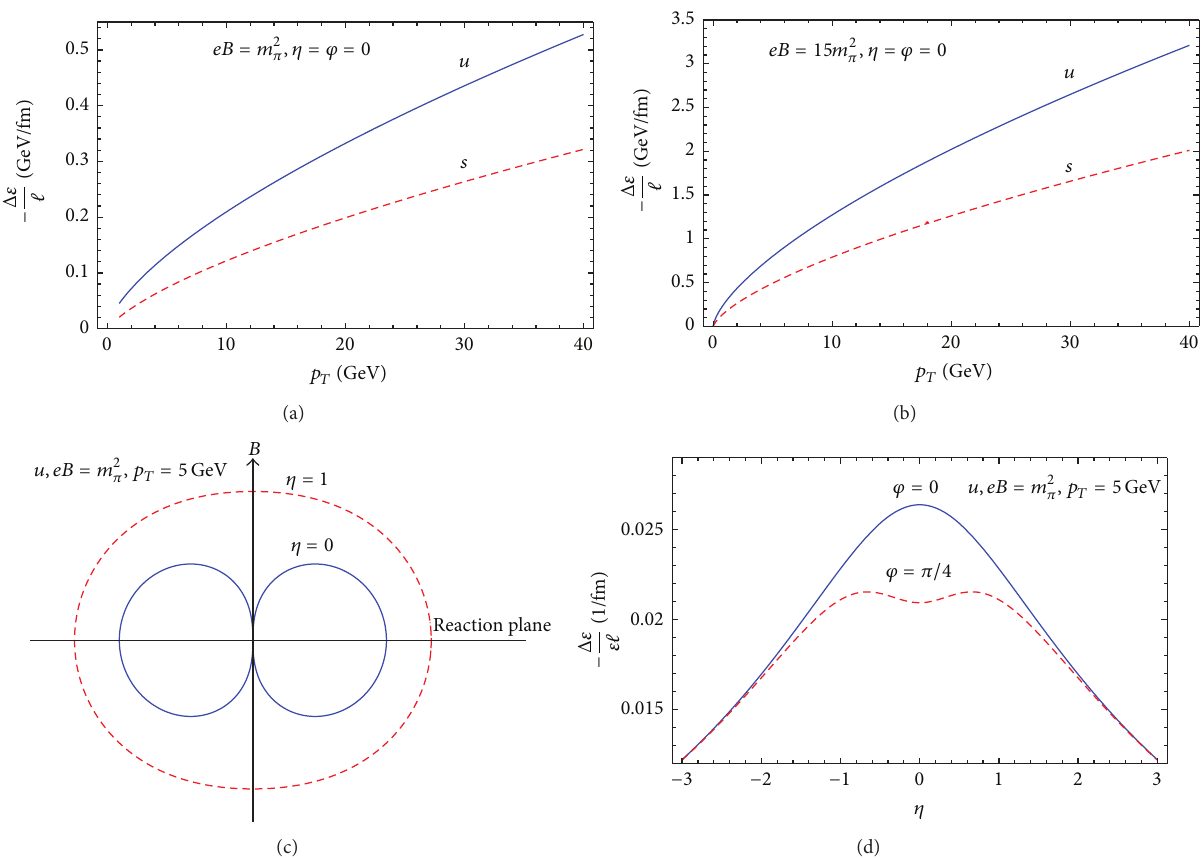
= 5 GeV and 𝜂 = 0,1 , and (d) fractional energy loss 𝑇